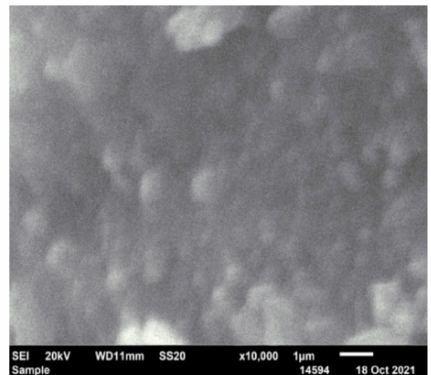
Figure 4. SEM image of magnetic composite.